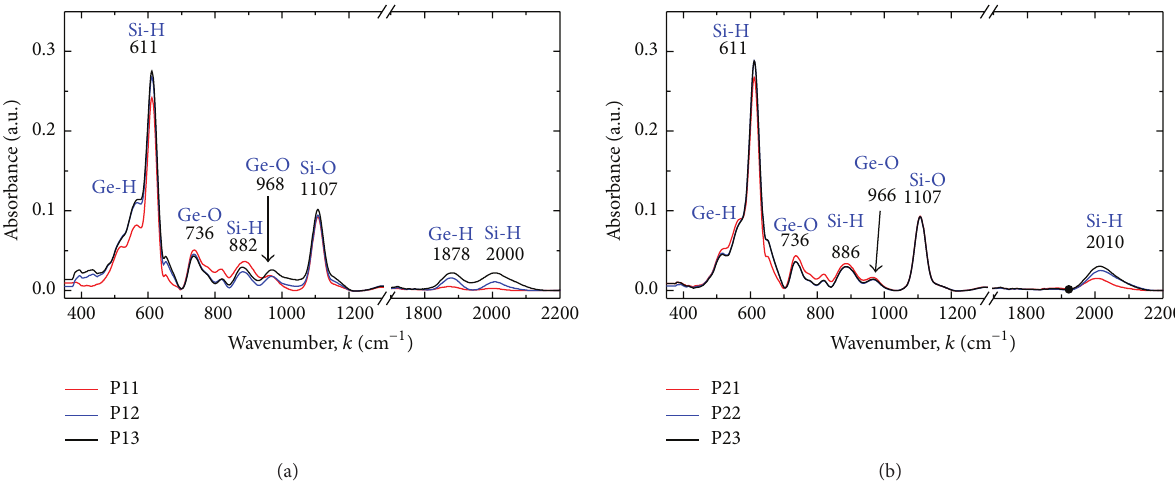
Figure 7: FTIR spectra of two series of pm-Si 𝑥 Ge 𝑦 :H films. (a) Series #1: SiH 4 /GeH 4 = 1 and (b) Series #2: SiH 4 /GeH 4 =